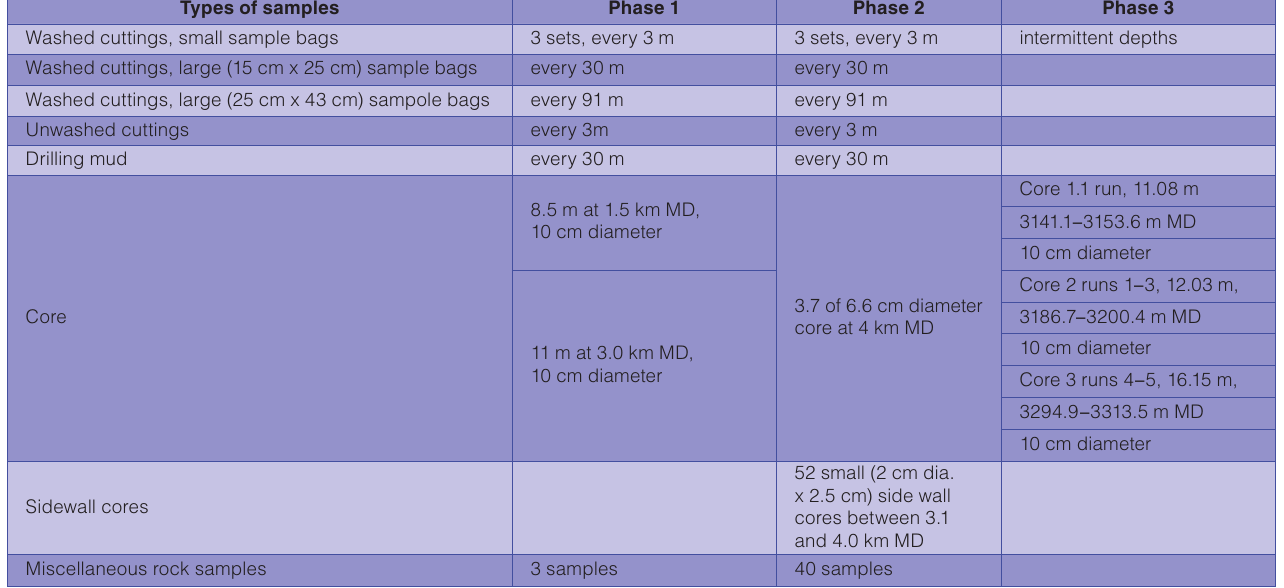
Table 2. Summary of Physical Samples Obtained from SAFOD.